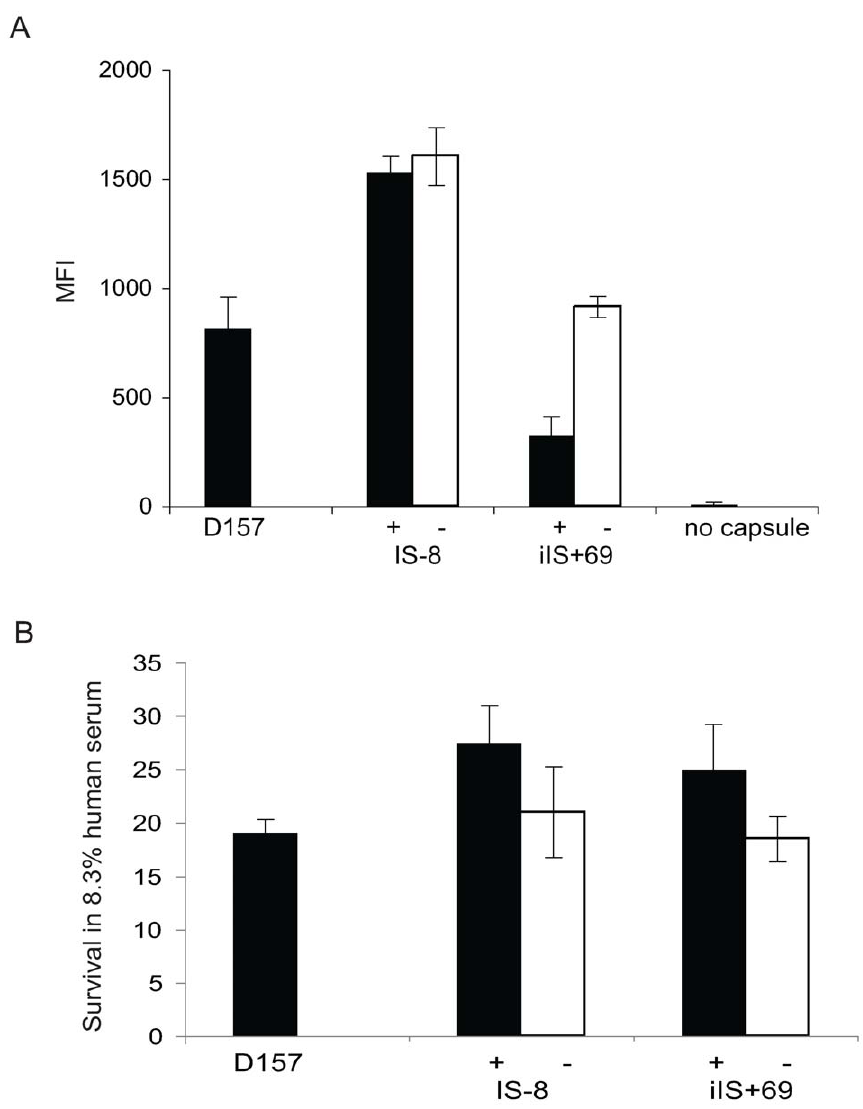
Figure 3. Polymorphic IGRs do not influence capsule expression or complement resistance. A: Relative amount of capsule detected by FACS. Results are shown as mean fluorescense index (MFI; calculated as the geometric mean multiplied by the percentage of positive cells). B: Survival in 8.33% human serum after 1 hour incubation at 37(C. Experiments were performed in duplicate on at least three independent occasions, and error bars indicate the SD. White bars represent isogenic control strains without IS 1301 in the